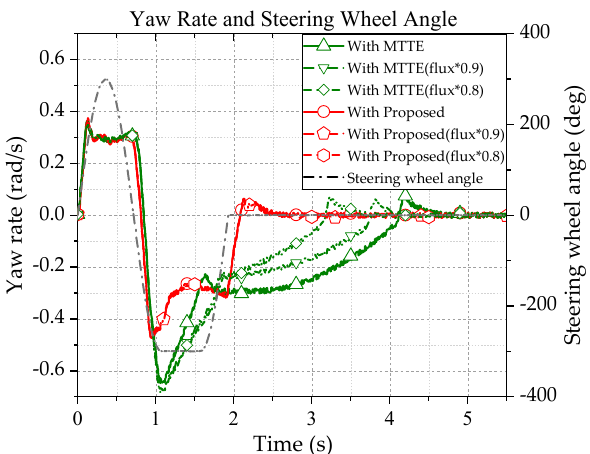
Figure 12. Comparison of the yaw rate between the vehicle with MTTE and with proposed control strategy under the change of flux linkage.